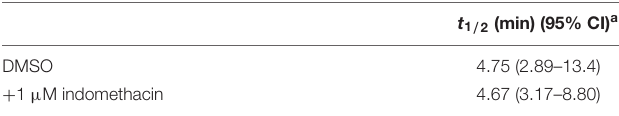
TABLE 1 | Effect of indomethacin on the mean [ 3 H]CP55940 of dissociation rate from membranes of CHO cells expressing hCB1R.